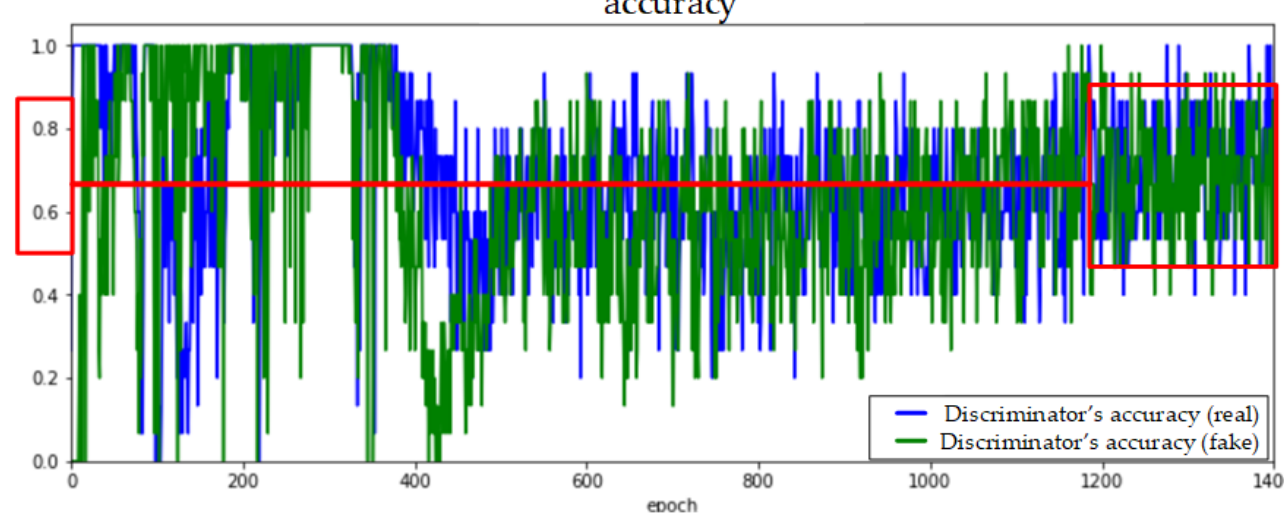
Figure 9. Training process of bearing outer ring injury.